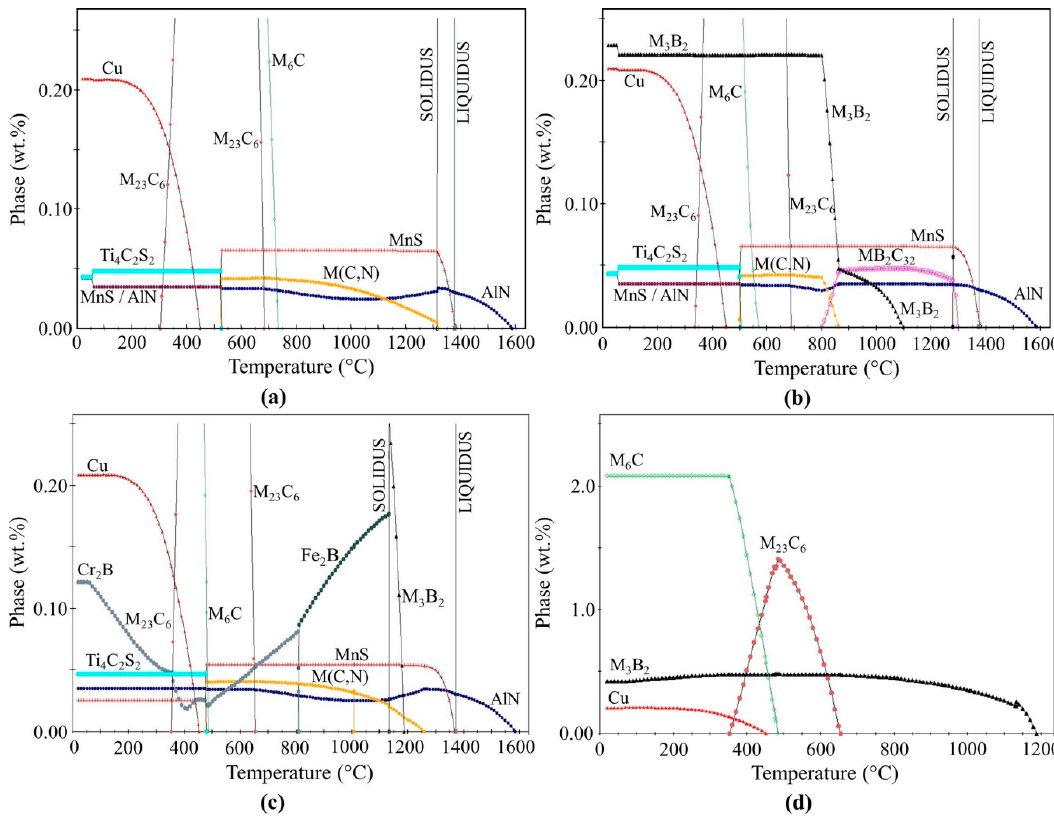
Figure 3. Amount of predicted phases (wt%) at equilibrium conditions calculated with JMatPro software in studied TWIP steels: ( a ) TW-B0, ( b ) TW-B1 and ( c,d ) TW-B2.